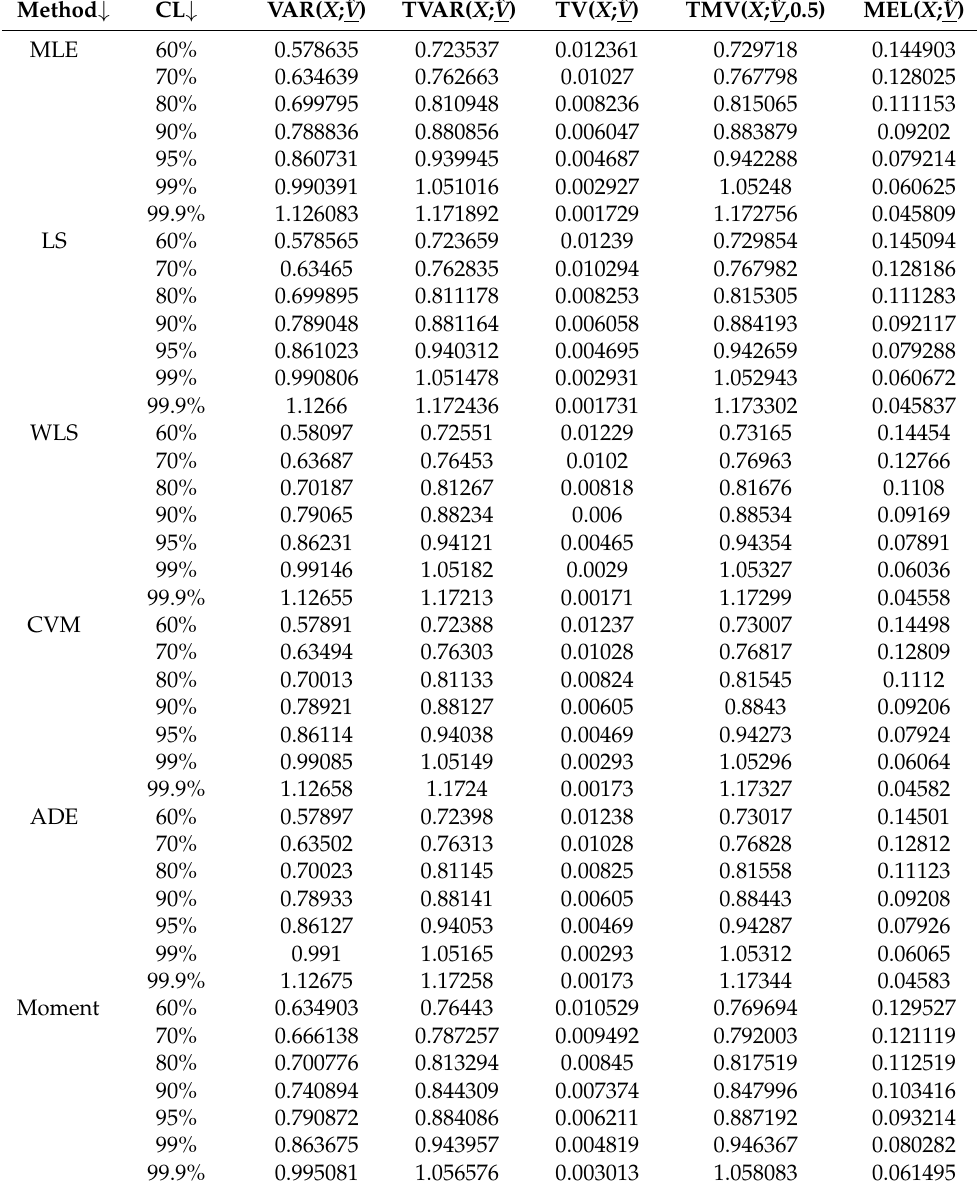
Table A5. The KRIs for the GRC under artificial data where n =